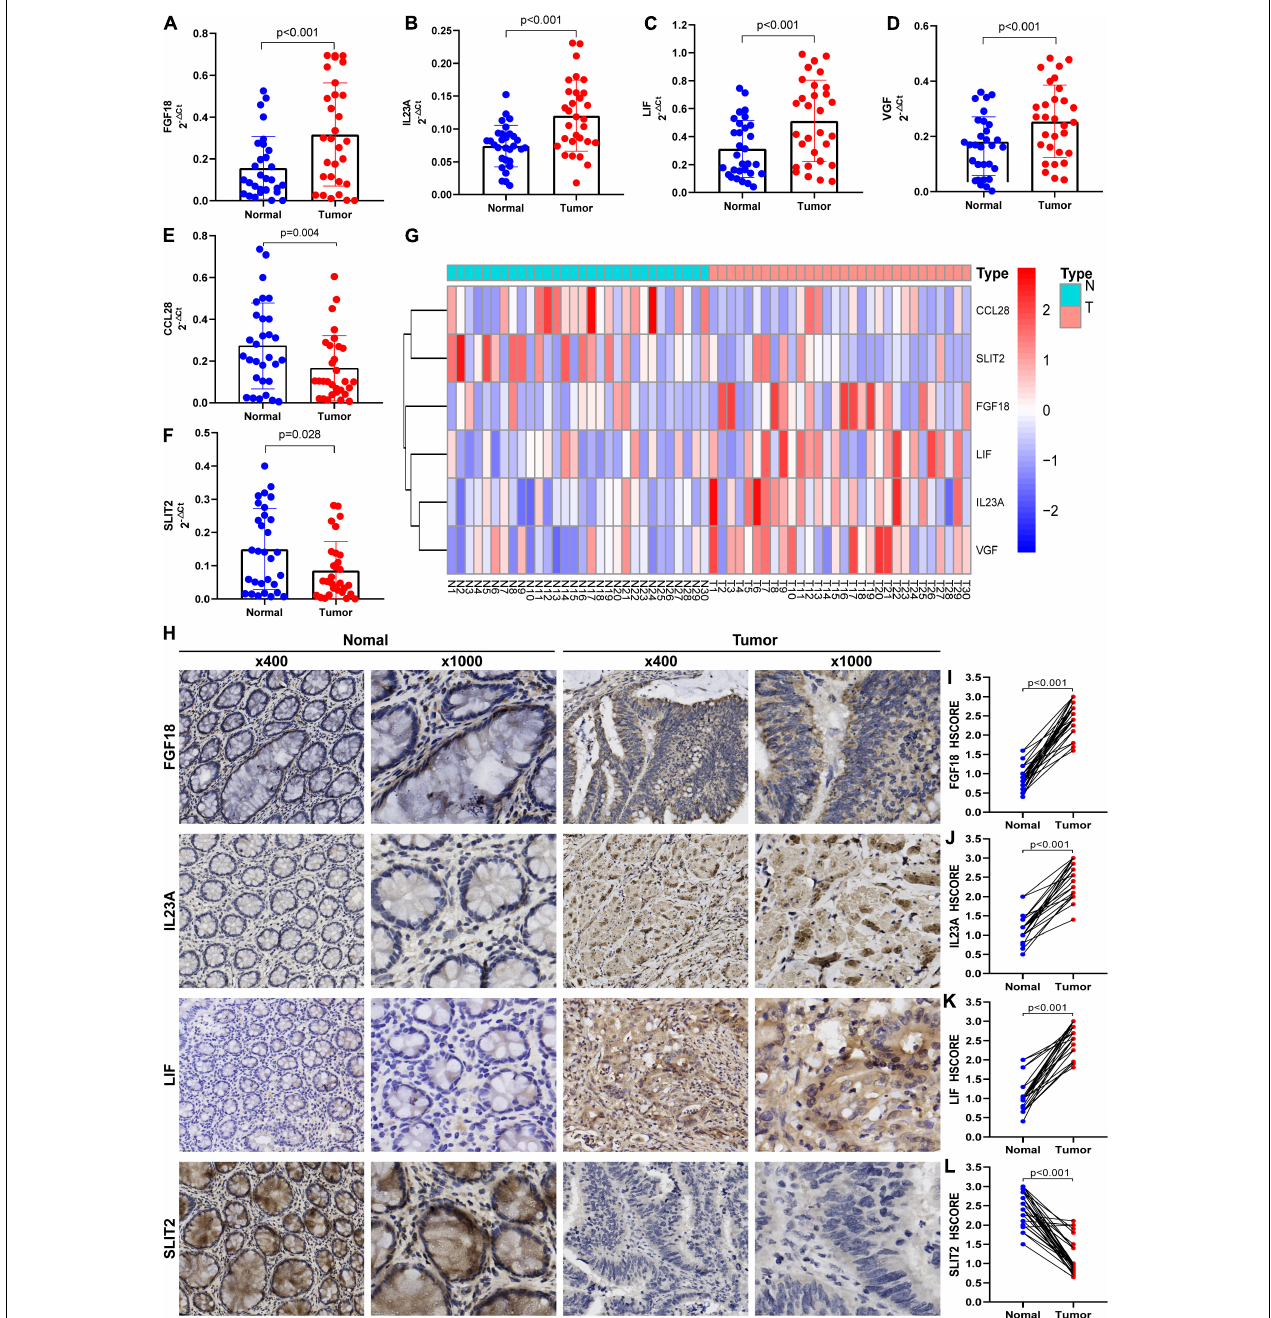
FIGURE 7 | Preliminary clinical specimen validation in 30 pairs of primary Stage II CRC and matched adjacent normal tissues. The gene expressions of FGF18 (A) , IL23A (B) , LIF (C) , VGF (D) , CCL28 (E) , and SLIT2 (F) in tumor and normal tissues were examined via qRT-PCR. The expression levels of the six immune genes in the IRGCRCII are illustrated in a heatmap (G) . The IHC assay (H) was used to examined the protein expressions of FGF18 (I) , IL23A (J) , LIF (K), and SLIT2 (L) . p < 0.05. CRC, colorectal cancer; qRT-PCR, quantitative real-time polymerase chain reaction; IHC, immunohistochemistry.